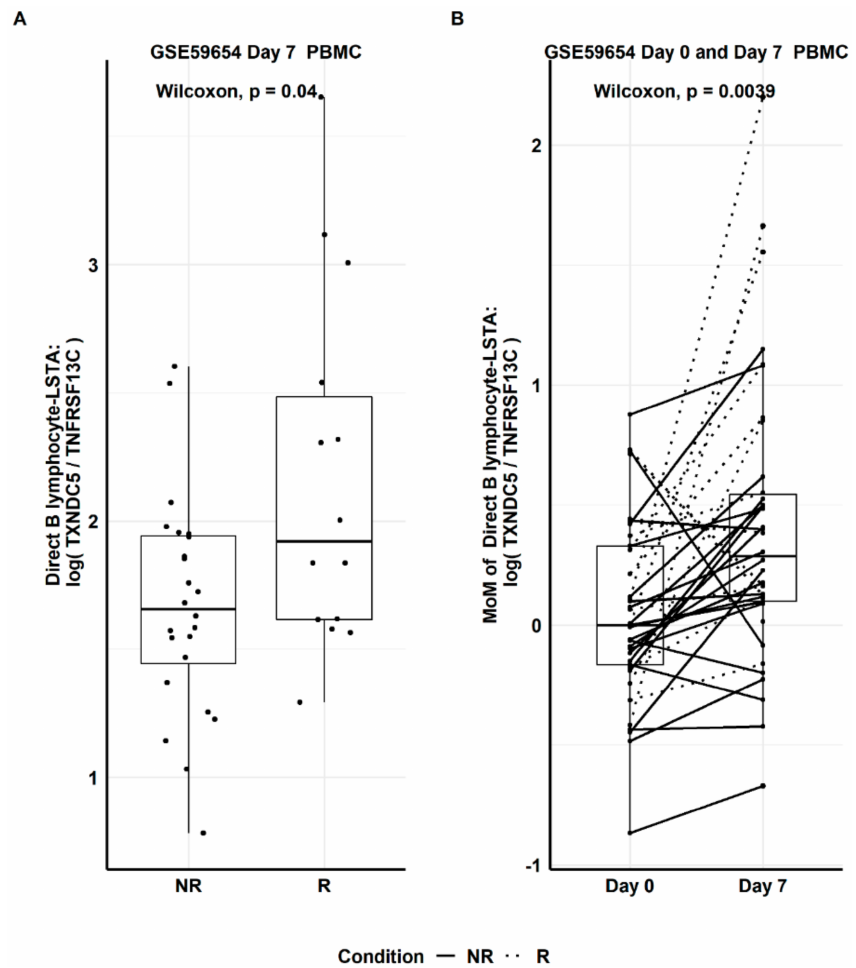
Figure 5. ( A ) Day 7 Direct B-lymphocyte LS-TA results of another target gene TXNDC5 in responder (R) and non-responder (NR) groups. ( B ) Paired Day 0 and Day 7 change in Direct LS-TA expressed as multiples of median (MoM) using the Day 0 group